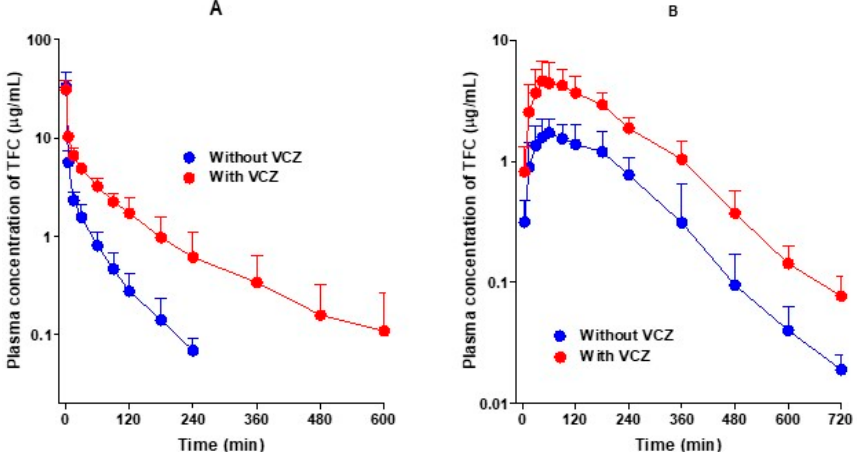
Figure 2. Average arterial plasma concentration–time curves of tofacitinib (TFC) after the administration of tofacitinib intravenously ( A ) without ( n = 5) and with ( n = 6) voriconazole (VCZ, 10 mg/kg for each drug) and orally ( B ) without ( n = 6) and with ( n = 7) voriconazole (20 mg/kg for each drug) to Sprague–Dawley rats. Bars represent standard deviation.